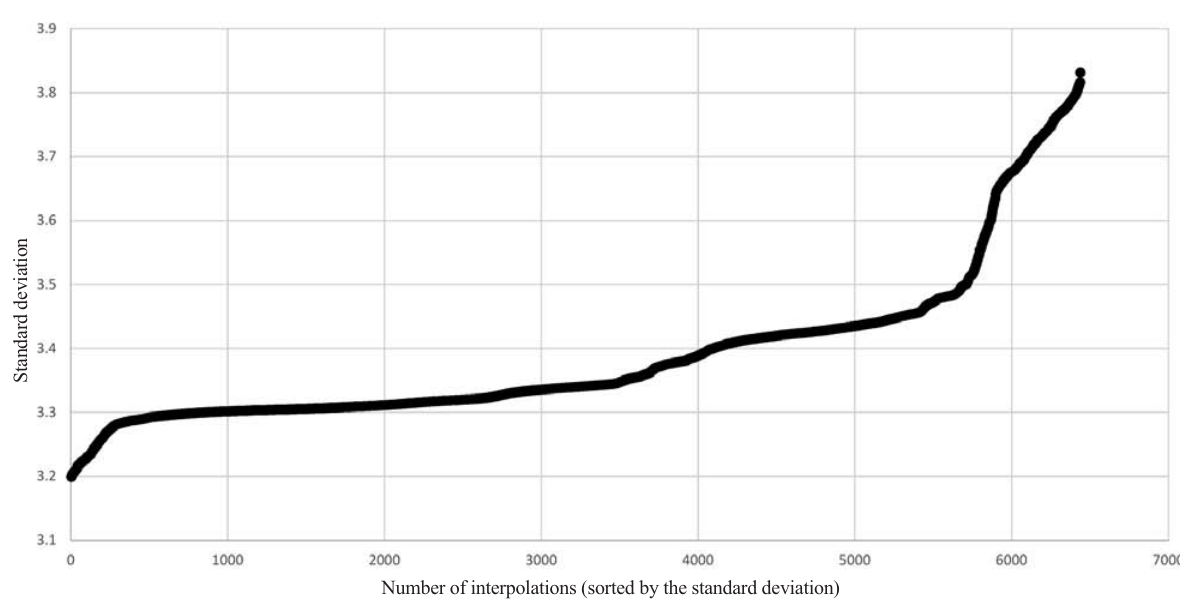
Number of interpolations (sorted by the standard